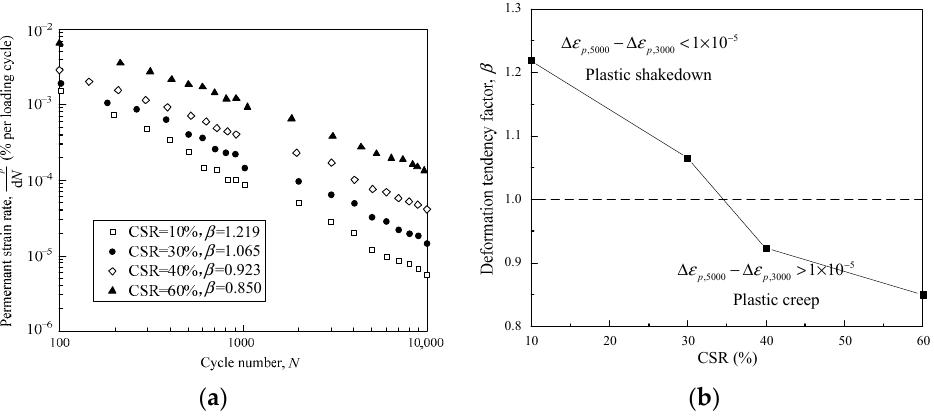
Figure 15. Permanent deformation properties of subgrade materials: ( a ) permanent strain rate plotted against loading cycles in double-log coordinate; ( b ) the relationship between β and CSR. (Data calculated from Wang and Zhuang, 2021) [20].